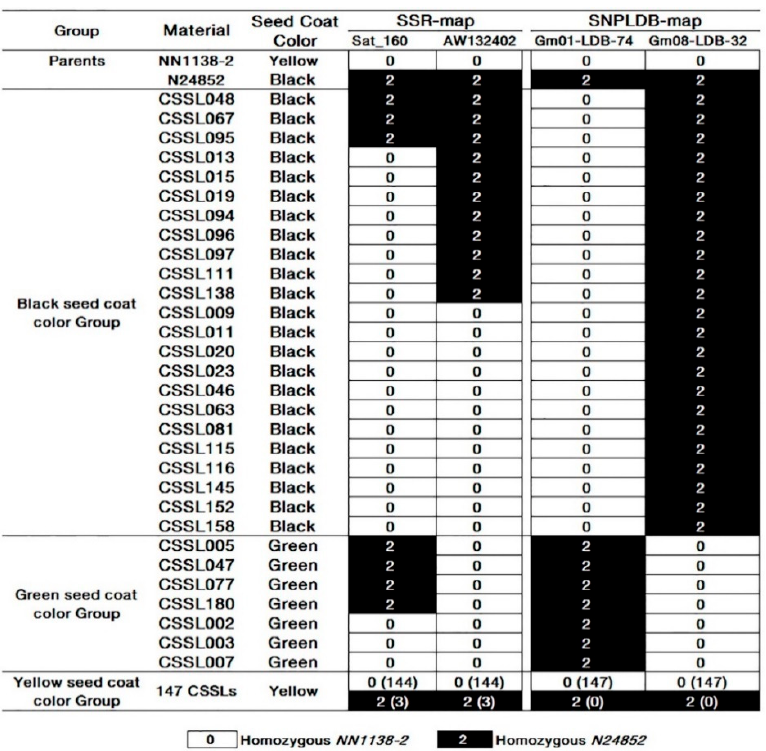
Figure 2. Identification of wild alleles for seed coat color using bulk segregant analysis. SSR-map, the physical map constructed with SSR markers; SNPLDB-map, the physical map constructed with SNPLDB markers. The seed coat color (SCC) was classified as yellow, green and black in SojaCSSLP5 , including 147, 7 and 23 in a total of 177 CSSLs, respectively. 0(144) or 0(147) represent the number of lines with genotype 0 (homozygous NN1138-2 ) are 144 or 147, while 2(3) or 2(0) represent the number of lines with genotype 2 (homozygous N24852) are 3 or 0. Table 2. Markers identified for SCC and DTF in SSR-map and SNPLDB-map.